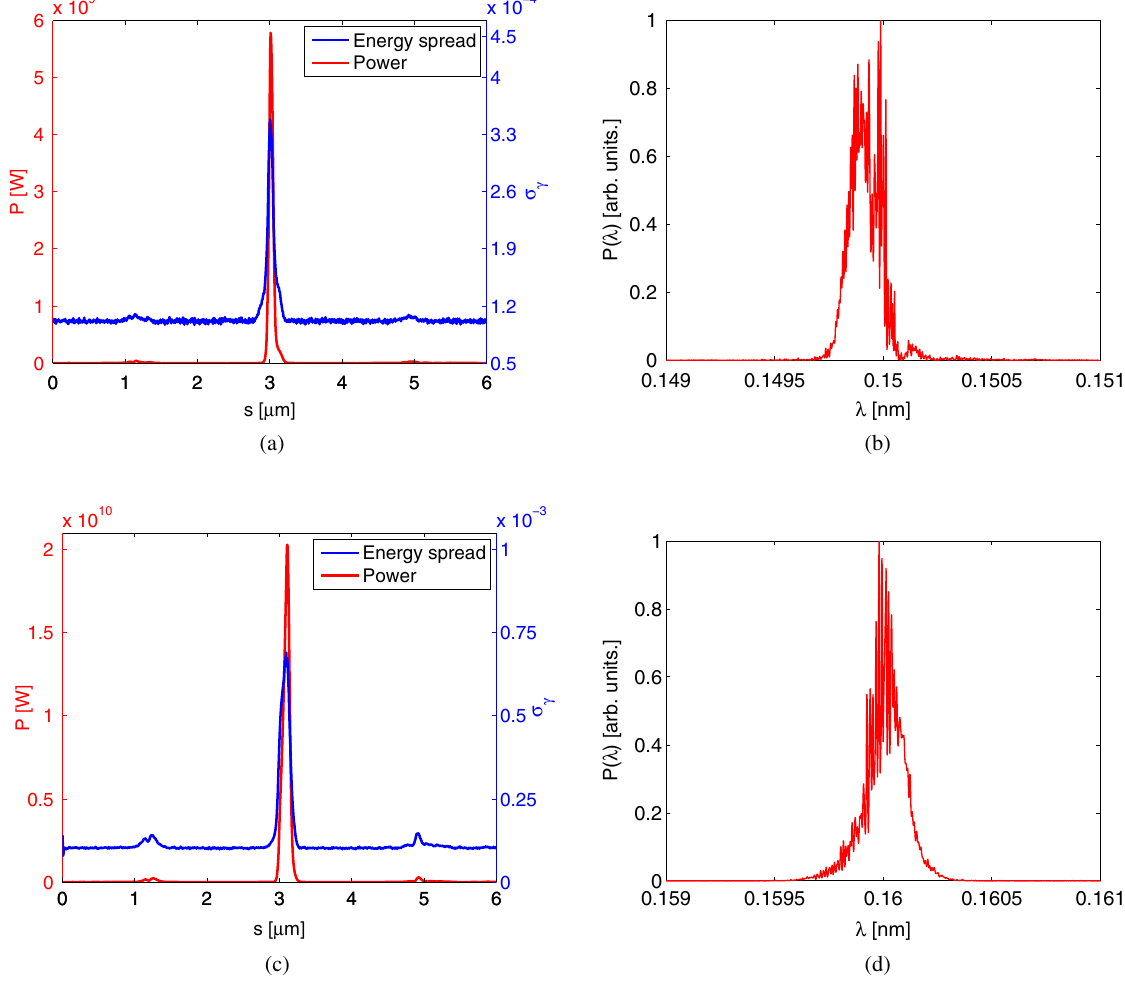
FIG. 11. (a) Power (red line) of the first FEL pulse and the energy spread of the electron beam at the end of the first undulator section. (b) Spectrum of the first FEL pulse. (c) Power (red line) of the second FEL pulse and the energy spread of the electron beam at the end of the second undulator section. (d) Spectrum of the second FEL